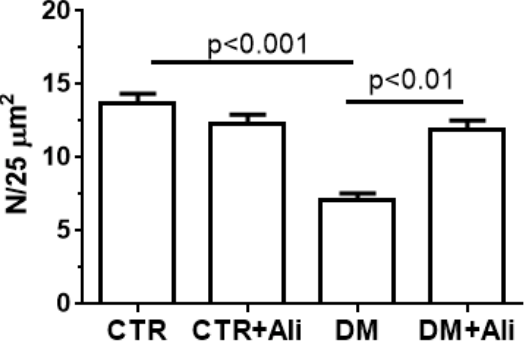
Figure 3. The number of mitochondria per field of view (25 µ m 2 ). The number of examined fields of view was 30–50 in each group. Table 1. Indicators of respiration and oxidative phosphorylation of the mouse skeletal muscle mitochondria of the experimental groups.